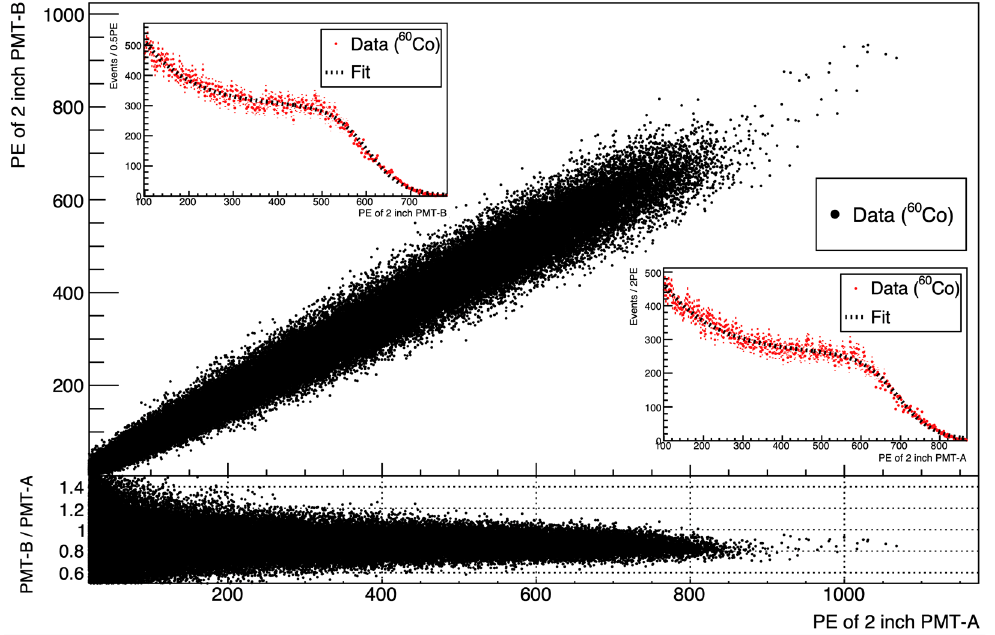
Figure 4. Observed light yield of sample B3, obtained from two H7195 PMTs using the setup shown in Figure 3a. A clear PE correlation is observed between the two PMTs. The inset presents a 1D projection plot for the observed PE. The upper (lower) inset corresponds to the PE distribution of PMT-B (PMT-A). Each PE distribution is fitted to determine the Compton edge.